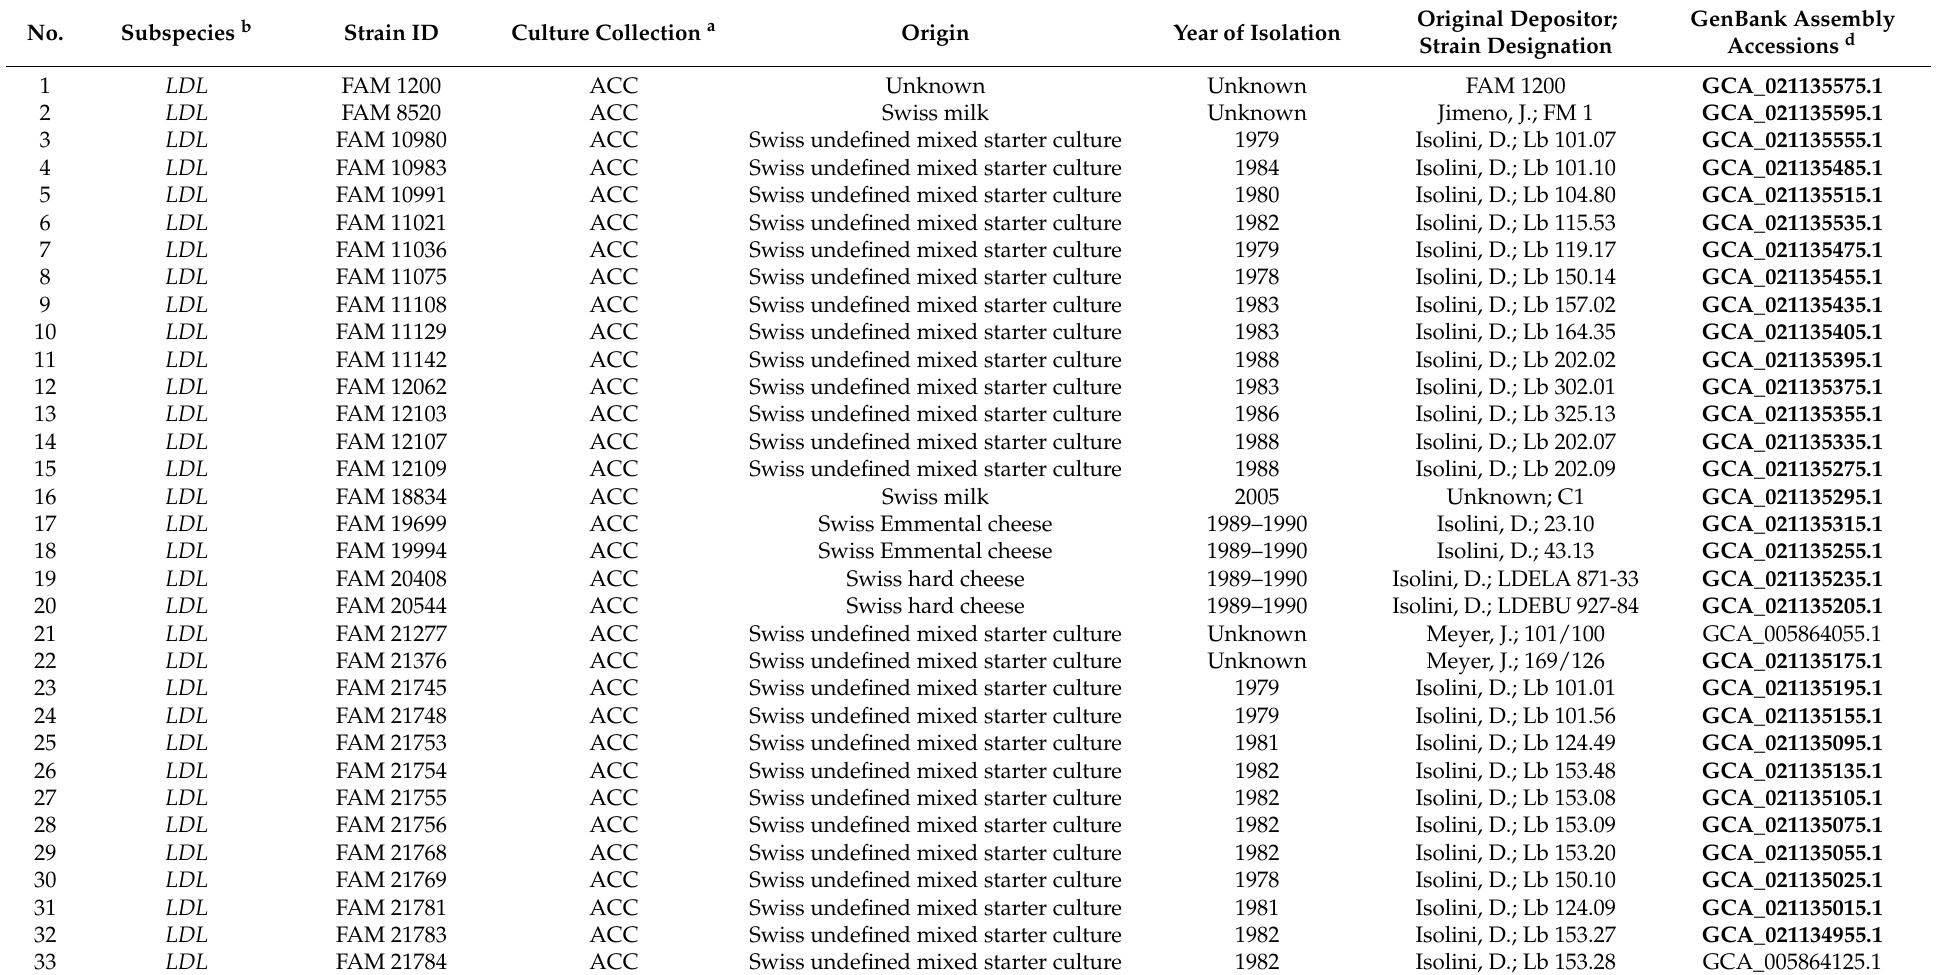
Table 2. Bacterial strains and their taxonomic affiliation, origin, and year of